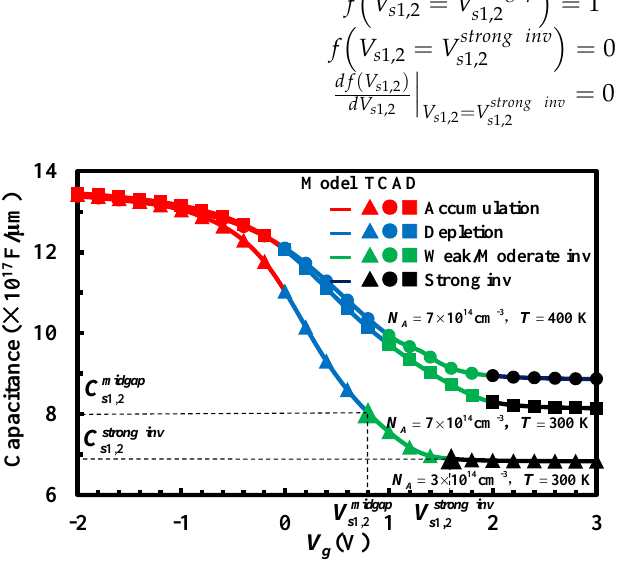
Figure 2. High-frequency capacitance – voltage curve of the upper or lower MIS structure in the stacked bonding structure.